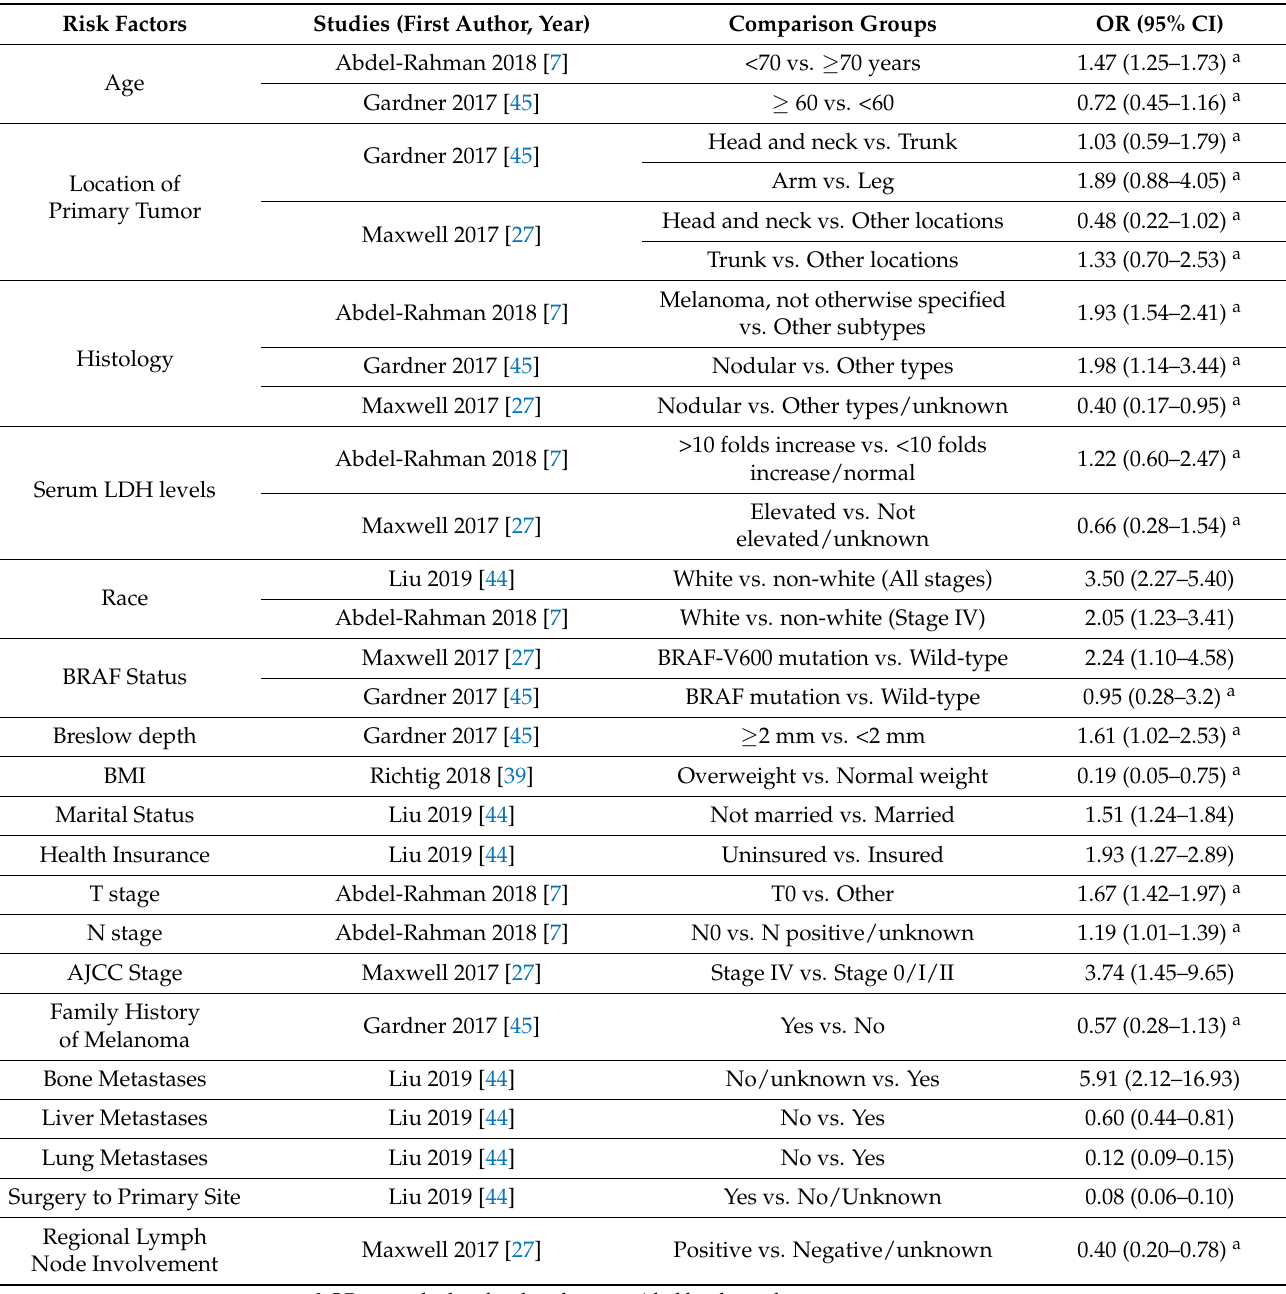
Table 4. Summary of other risk factors associated with MBM